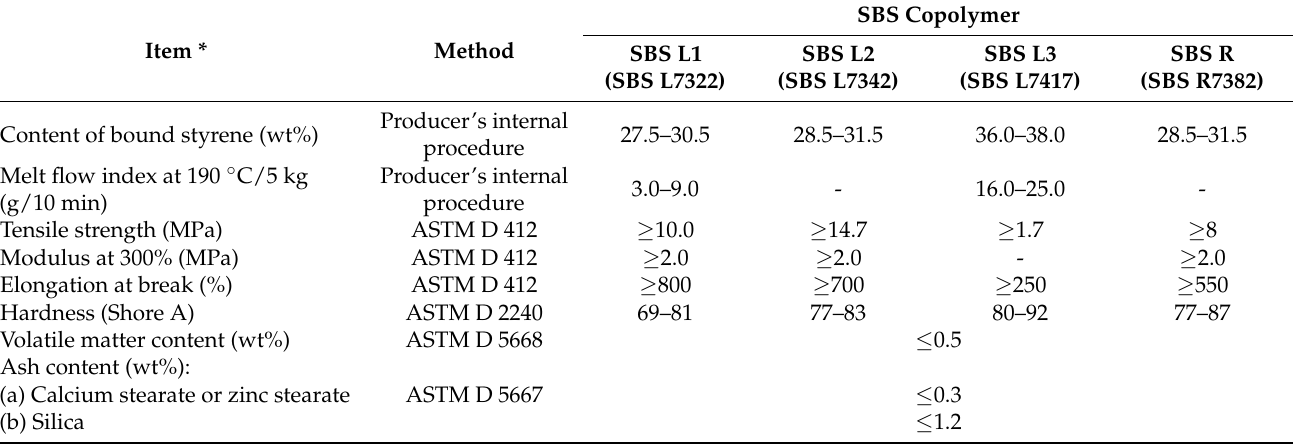
Table 1. Physico-mechanical properties of the selected styrene–butadiene–styrene block